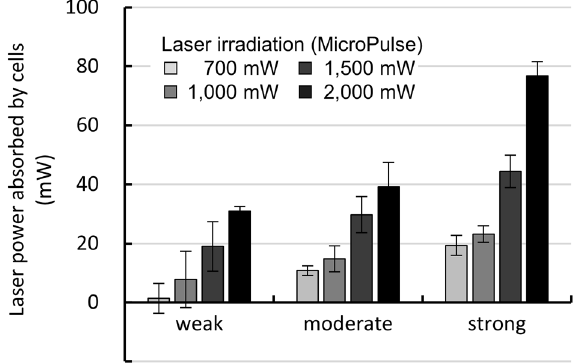
Figure 1. Differences in power absorbed by cells depending on stain intensity and laser irradiation power. The power of the laser transmitted through the cell culture surfaces were measured, and the laser power (mW) absorbed by the cells was calculated using the cells without pigmentation as a blank (n = 5). Data are represented as mean ± standard deviation of the mean.